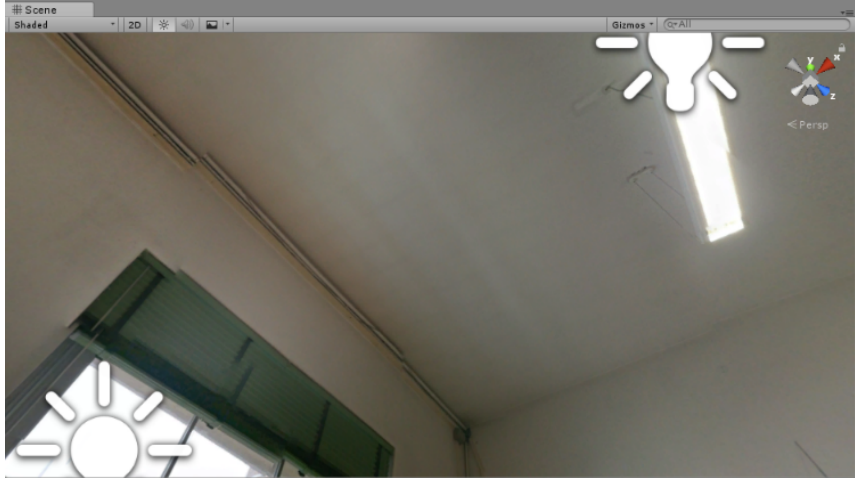
Figure 13. Automatic light positioning in Unity editor.